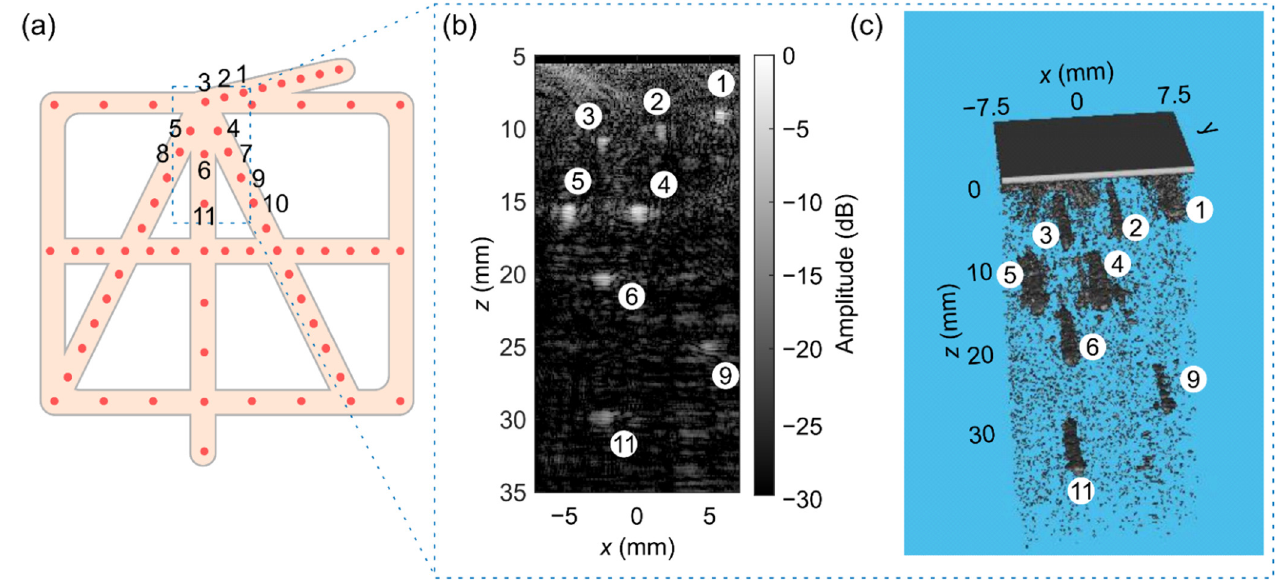
Figure 12. ( a ) Scheme of the wire phantom and numbered wires (the dashed rectangle depicts the field of view of the transducer). The reconstructed ( b ) 2D and ( c ) 3D images.